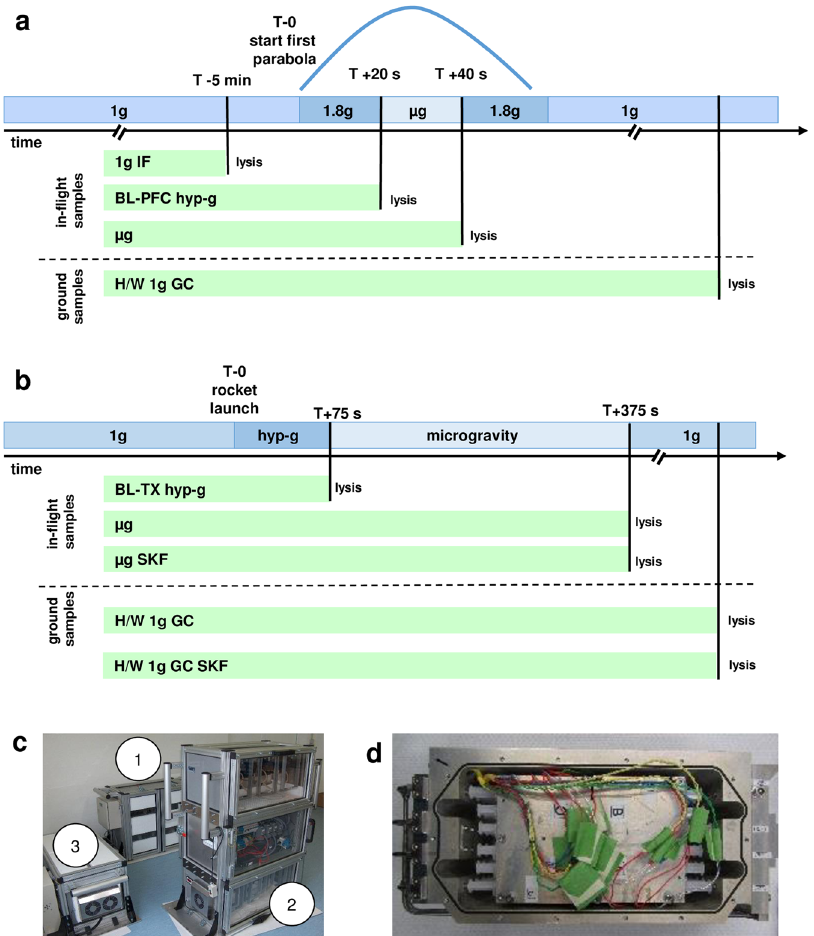
Figure 1. Sample lysis scheme. ( a ) U937 cells were analyzed during the 19 th DLR parabolic flight campaign. In total, four sample groups were lysed at defined g conditions and time points: (1) 1 g in-flight (1 g IF) 5 min before the first parabola, (2) 1.8 g samples at the end of the first parabola after 20 s of the 1.8 g hypergravity phase; these samples also serve as baseline (BL-PFC hyp-g) directly before the microgravity phase, (3) at the end of the first parabola after 20 s of microgravity ( μ g) phase, and (4) 1 g hardware ground controls (H/W 1 g GC), directly after the flight inside the aircraft. ( b ) U937 cells were investigated during the TEXUS-49 suborbital ballistic rocket campaign. Overall, five sample groups were lysed at set time points and g conditions: (1) the baseline (BL-TX hyp-g) group monitored the first 75 s of the flight after liftoff including hypergravity and vibrations, (2) microgravity samples ( µ g) were lysed 375 s post-launch, resulting in 300 s of microgravity time, (3) microgravity samples lysed 375 s post-launch with the cation ion channel inhibitor SKF-96365 ( µ g SKF), (4) 1 g hardware ground controls (H/W 1 g GC) lysed approximately 15 min after launch and (5) 1 g hardware ground controls with SKF-96365 (H/W 1 g GC SKF) lysed approximately 15 min after launch. ( c ) Experiment hardware of the parabolic flight (19 th DLR PFC). In-flight experiment system for parabolic flights on board the Airbus A300 ZERO-G. Experiment hardware structure which consists of an incubator rack to store the cell containers at 36.5 °C before the experiment (1), an experiment rack, in which all technical aggregates are accommodated for the execution of the experiment and where the living cells are processed during altered gravity (2), and a cooling rack to store all cell containers at 4 °C after the injection of the lysis solution until landing (3). ( d ) Experiment hardware of the suborbital ballistic rocket (TEXUS-49) experiments. TEXUS consists of a VSB-30 engine (not shown) and of the payload structure. Sets of three sterile syringes were filled with cell suspension, medium with or without SKF-96365, and lysis buffer connected by a T-piece with small plugs at the outlet ports to prevent premature contact of the fluids. The syringe systems are accommodated in tempered and vacuum-resistant containers